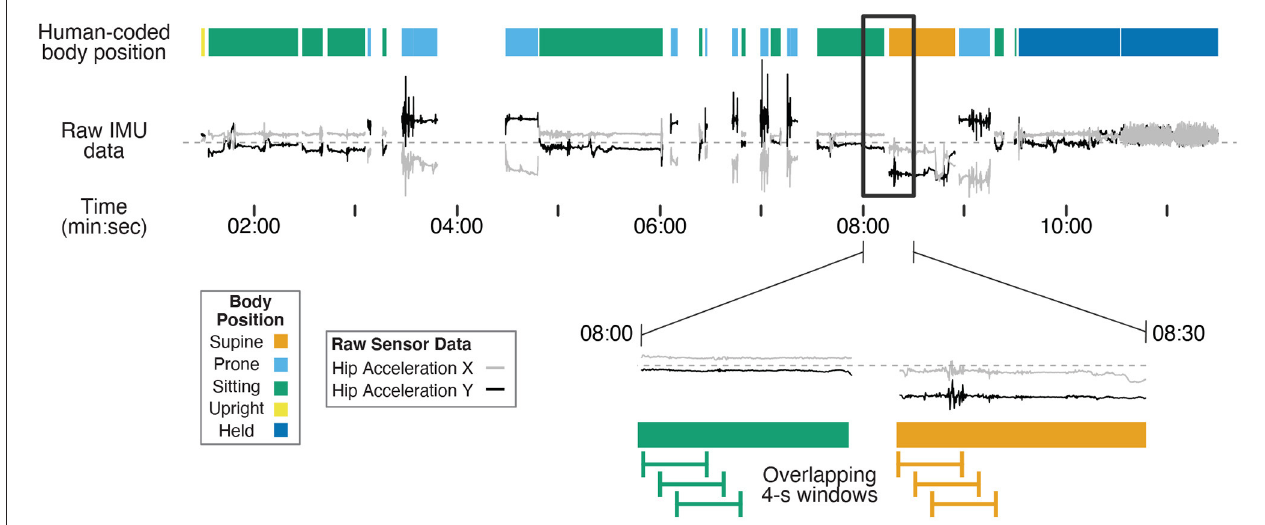
FIGURE 1 | Example timeline showing human-coded body position (colored bars at the top) synchronized with example IMU data (gray and black lines) for one 12-month-old (non-walking) participant’s entire session. Two example IMU signals were selected (acceleration in the X and Y axes from the hip sensor) to demonstrate differences in motion data over time in different body positions. The black rectangle shows a 30-s subset of data that are magnified in the bottom timeline. The green and orange lines illustrate 4-s long windows that are shifted in 1-s steps throughout the session to capture discrete body position events. Motion features were calculated within each 4-s window from the raw data to characterize movement in each window for training and prediction. The activities before 7:30 were from the free play portion, and the activities following 7:30 were from the guided portion of the